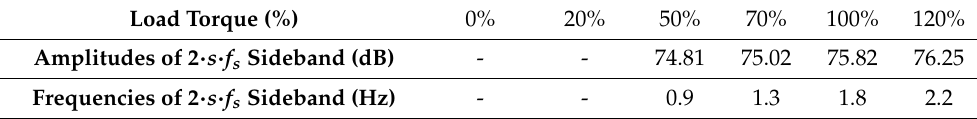
Figure 10. Influence of the load torque on the ( a ) amplitude and the ( b ) frequency of the 2· s · f s spectral components.